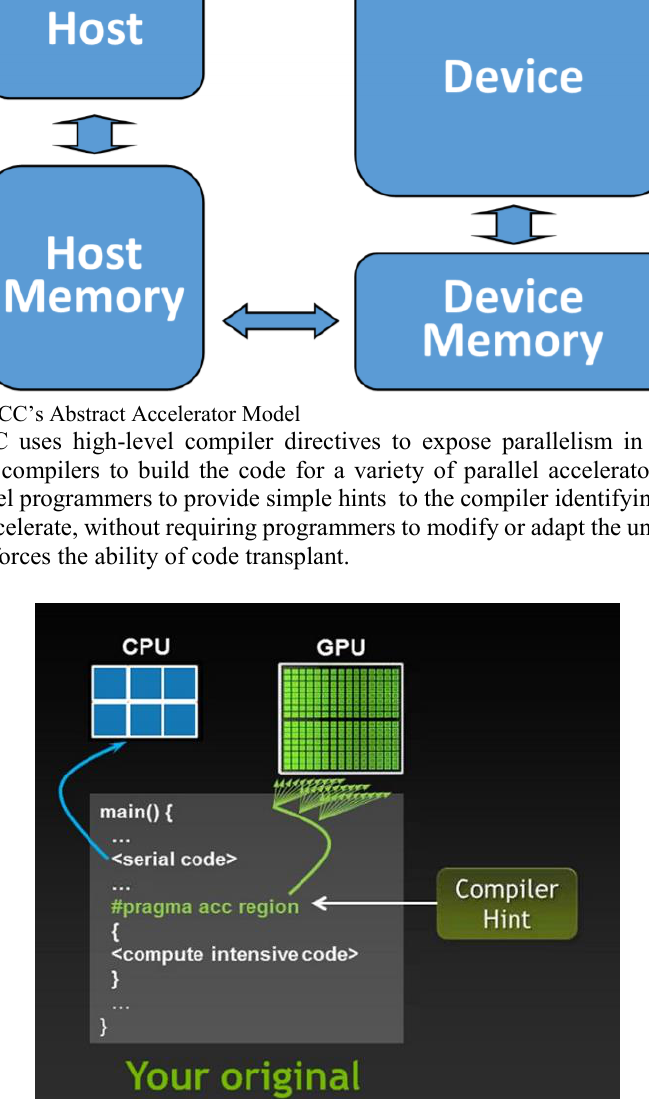
corresponding codes are difficult to be ported to GPUPWA (OpenCL).